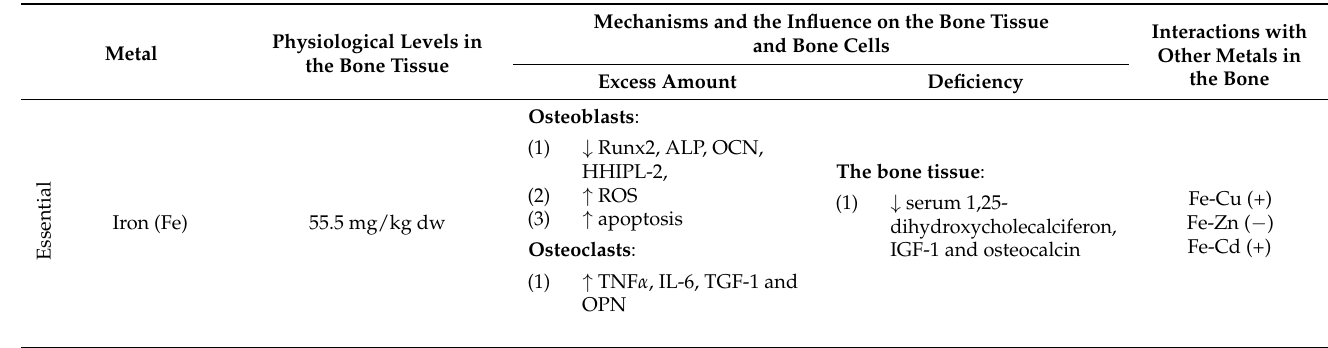
Table 3. Summary table of the effects of Fe, Zn, Cu, Cd, and Hg on bone metabolism, including the interactions between elements (+, synergism; -, antagonism; +/ − , in some studies it was found as synergism, in others as